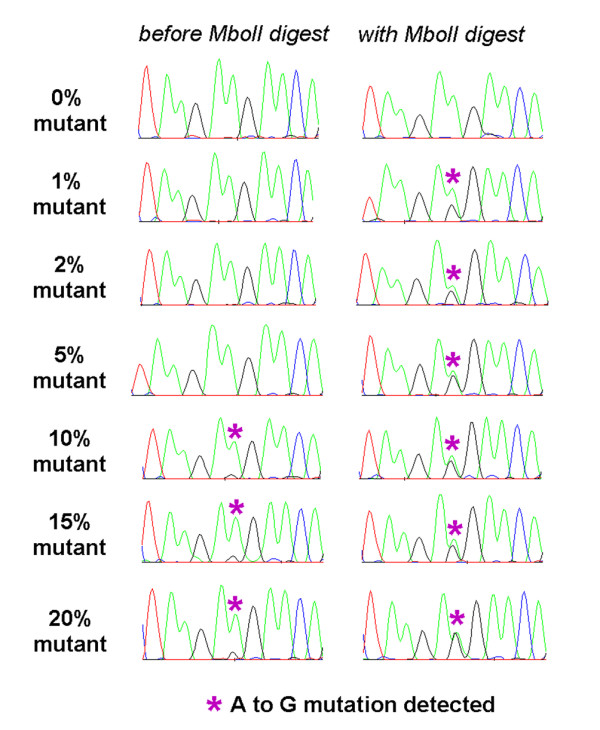
Sample electrophoretograms of sequence data with and without enrichment by digestion with MboII. The sequence of the region of interest is shown: coding residues 903–913 (residues 1195–1205 of ESR1; GenBank accession number M12674). The position of the detected A908G mutation is marked with asterisks.